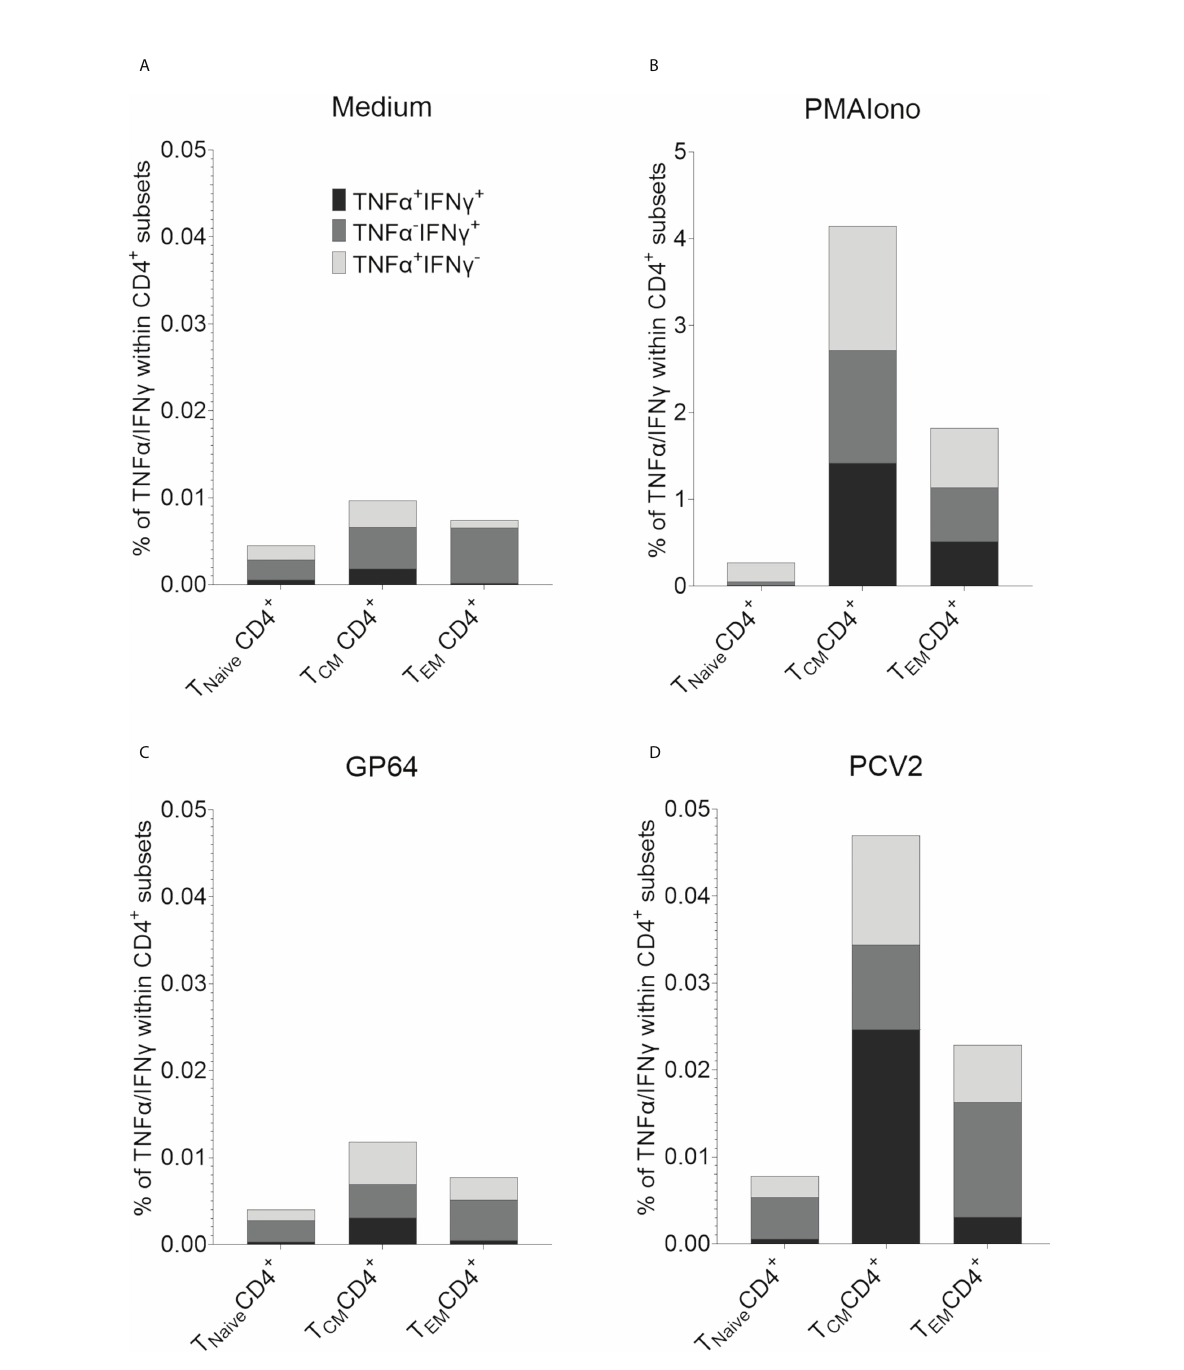
FIGURE 9 Intracellular cytokine staining for the detection of antigen-speci fi c TNF- a and IFN- g producing T cells after restimulation with PCV2-ORF2 protein. (A-D) Distribution of TNF- a and IFN- g within T Naive , T CM and T EM CD4 + cells after 18h of stimulation summarized for six different